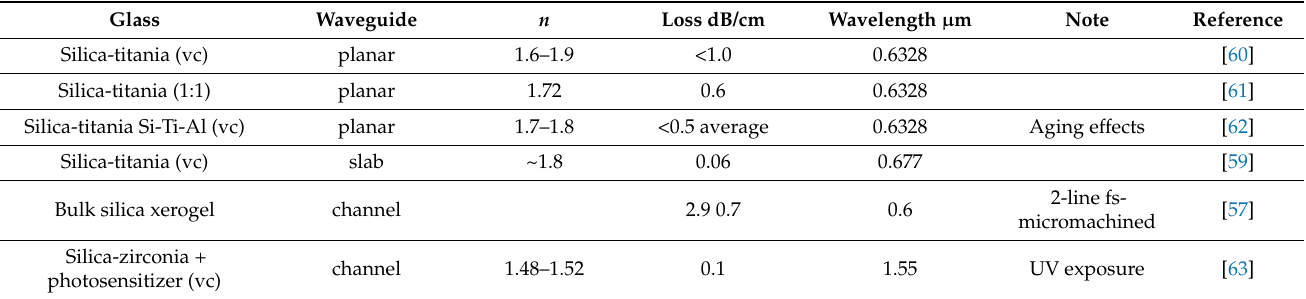
Table 1. Propagation loss of various optical waveguides fabricated by sol–gel technique (vc indi- cates that experiments were made on different glass compositions; TMSPM: trimethoxysilylpropyl